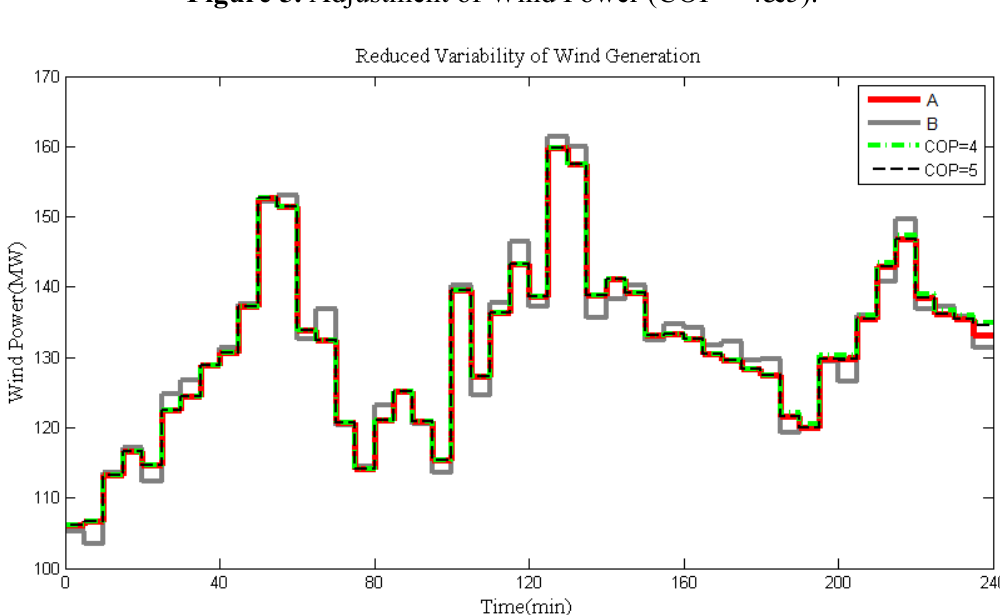
Figure 5. Adjustment of Wind Power (COP =